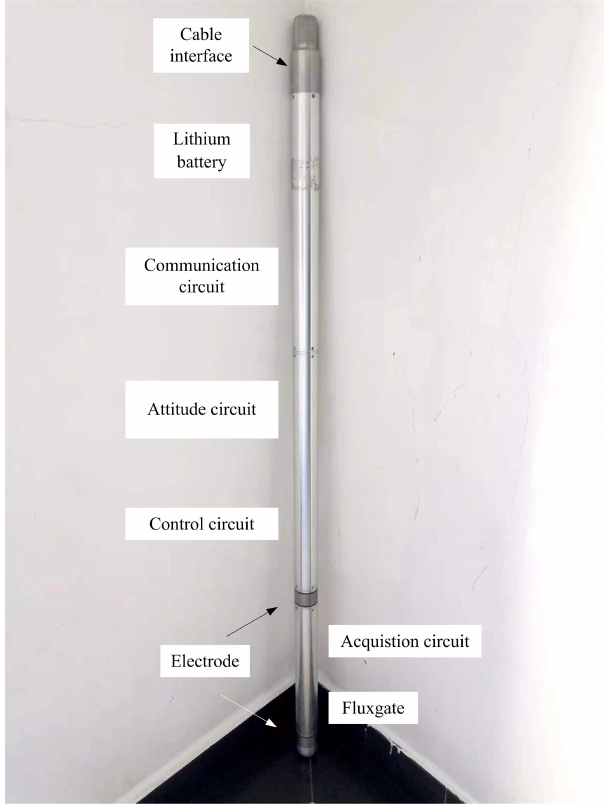
Figure 2. Picture of the borehole EMR. The probe top and cable connections communicate with the wellhead